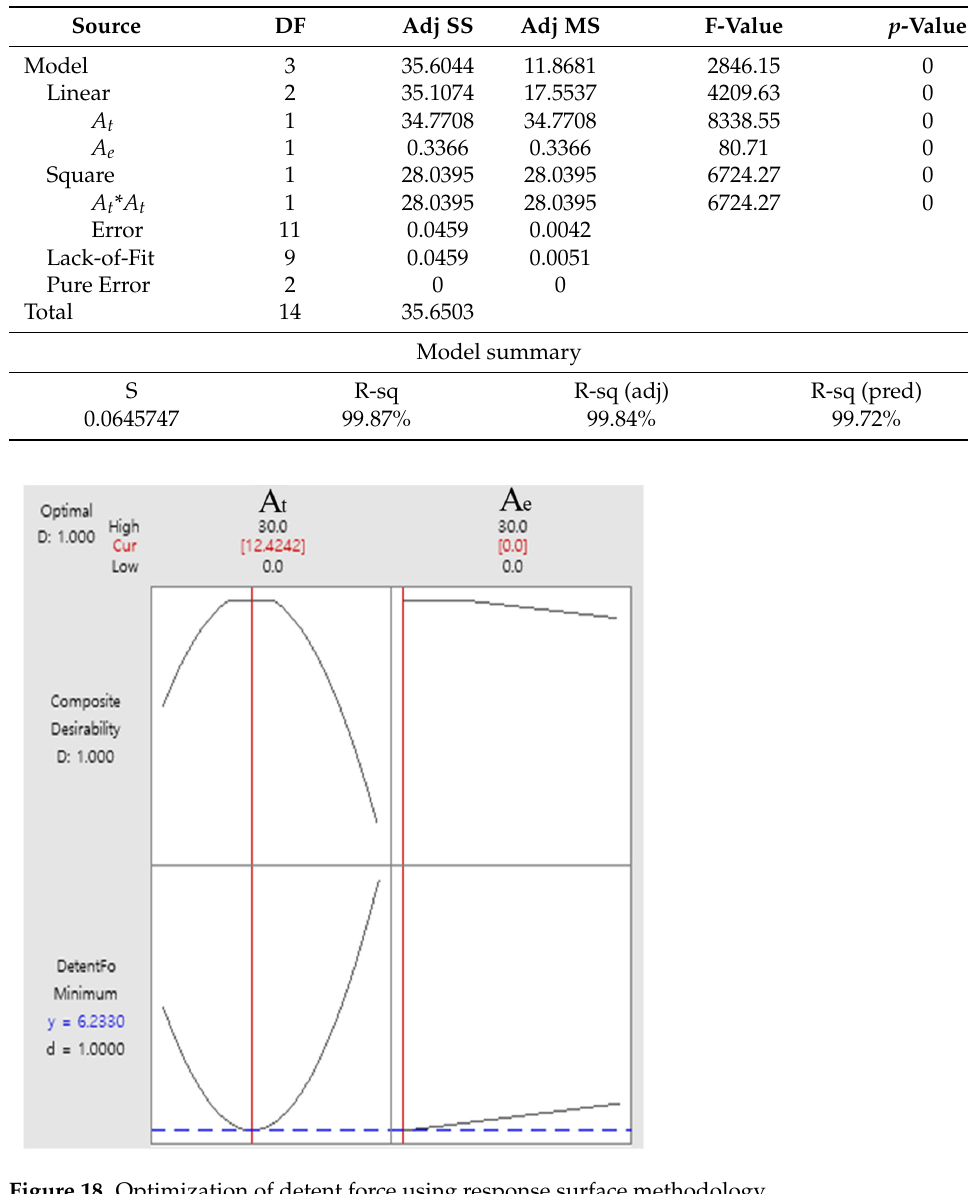
Table 10. Analysis of variance of end edge detent force.